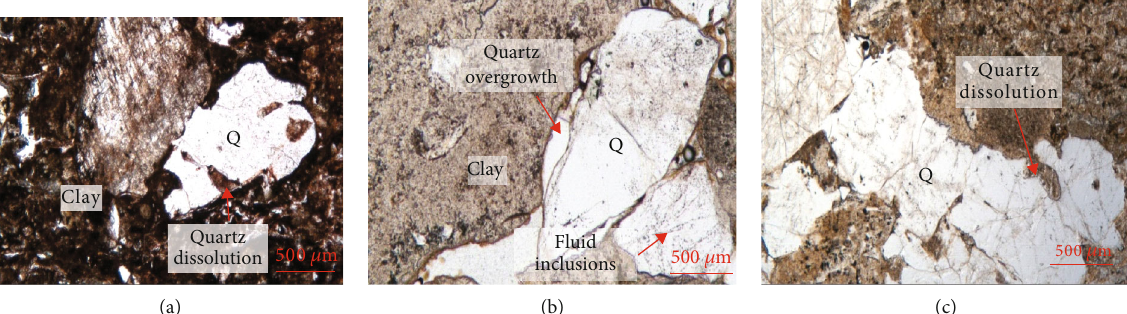
Figure 2: Morphological characteristics of quartz under the microscope. (a) Quartz replaced by and in fi lled with clay, with oil stains (sample B63; 2452m; T b ; 5 × ; plane-polarized light). (b) Inclusion-rich and oil-stained quartz overgrowth (sample D15; 4245m; T 1 polarized light). (c) Quartz dissolved and replaced by clay, with oil stains (sample AH2; 3313.56m; T T b =the lower Triassic Baikouquan Formation. 1